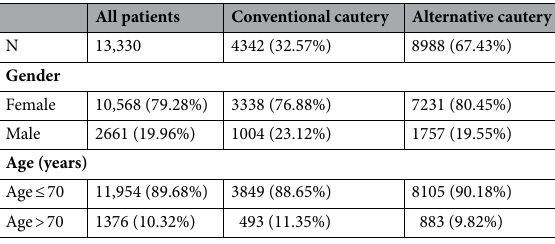
Table 1. Demographics.